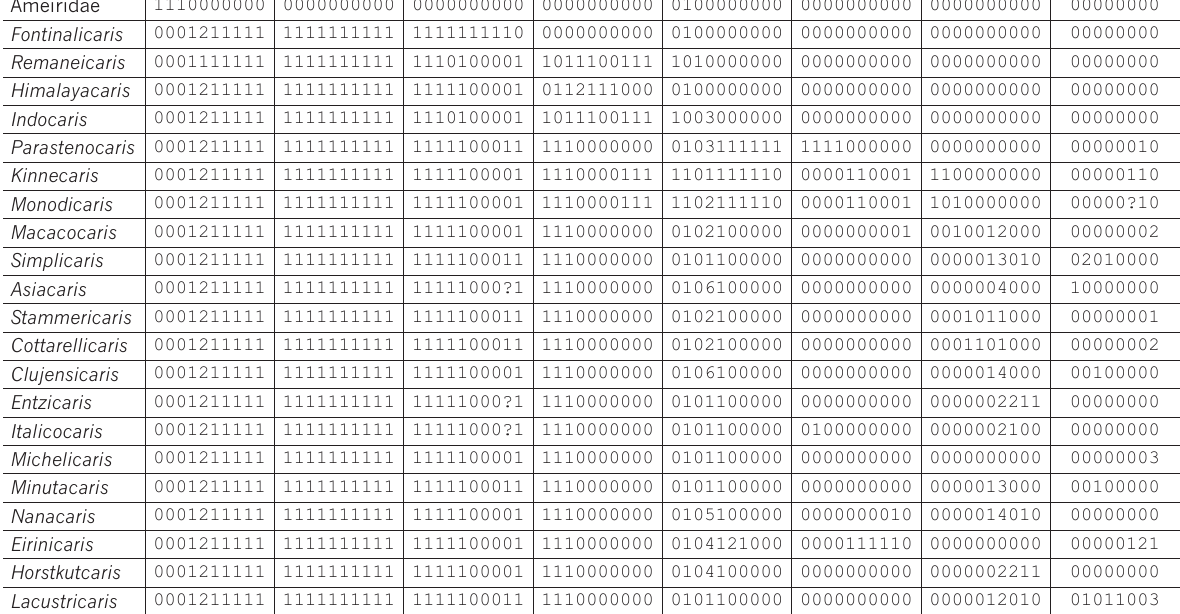
Table 1. Character matrix for phylogenetic reconstruction of the valid genera included by Schminke (2010) within the subfamily Parastenocaridinae. Character states polarized a priori; polarization from 0= most plesiomorphic to 4 = most apomorphic. ?= un - known state of the